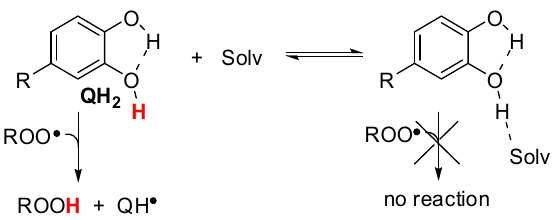
Figure 1. Oxygen consumption during the autoxidation of tetrahydrofuran (THF, 3.1 M) initiated by 2,2 ′‐ azobis(2 ‐ methylpropion ‐ amidine)dihydrochloride (AAPH, 0.025 M) at 30 °C without inhibitors (dash) or in the presence of quercetin (solid). ( A ) In phosphate buffer 0.1 M pH = 2.1 with quercetin 2.5 × 10 − 5 M; ( B ) In phosphate buffer 0.1 M pH = 7.4 with quercetin 5.0 × 10 − 6 M, vertical lines indicate the time lapse corresponding to the trapping of n = 2 peroxyl radicals.